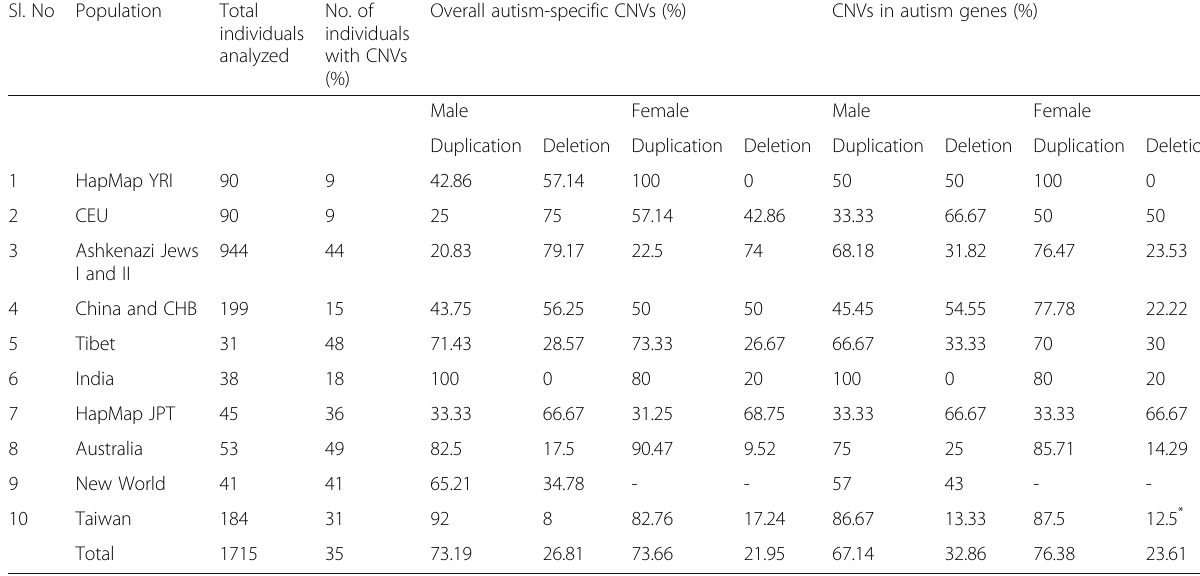
Table 1 Distribution of autism CNV duplication and deletion regions present across 12 populations Sl. No Population